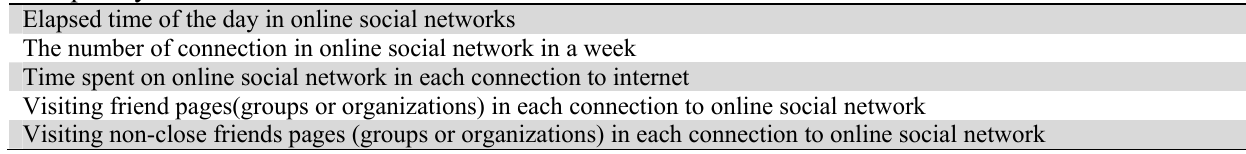
Frequency indexes of online social network Elapsed time of the day in online social networks The number of connection in online social network in a week Time spent on online social network in each connection to internet Visiting friend pages(groups or organizations) in each connection to online social network Visiting non-close friends pages (groups or organizations) in each connection to online social